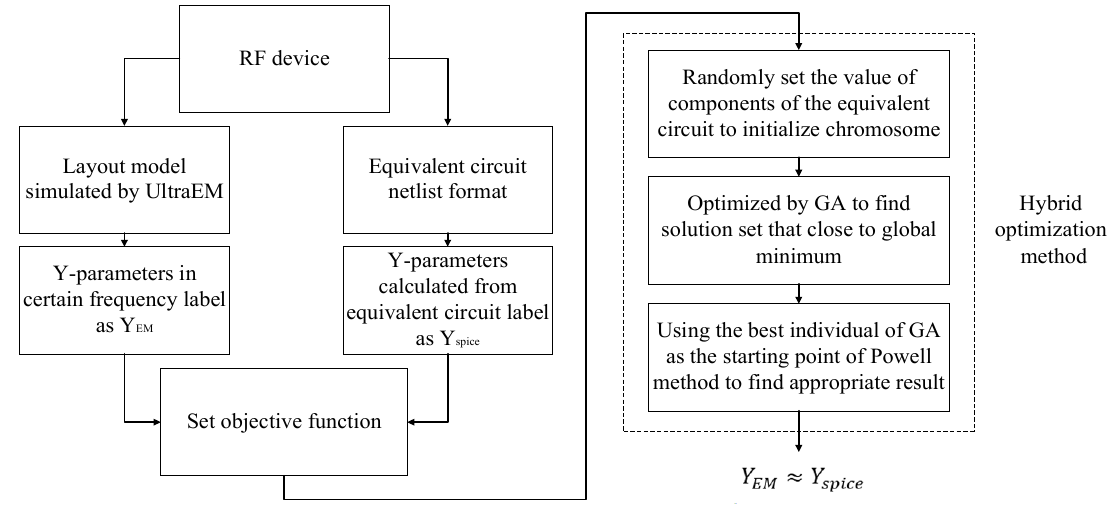
Figure 2. Flow chart model of the hybrid GA–Powell’s method.